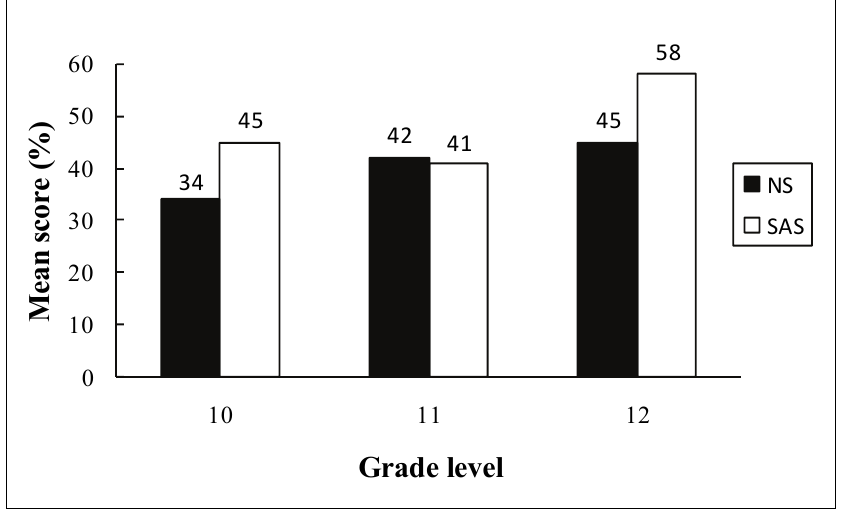
Figure 2 : Grade level performance of learners in the